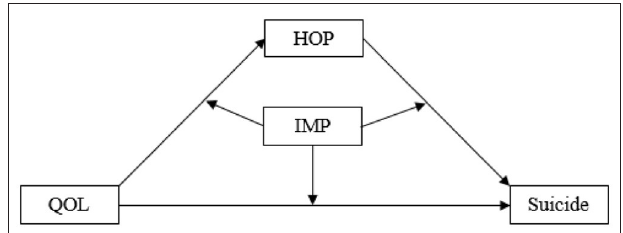
FIGURE 1 | A proposed moderated mediation model that links quality of life with suicide through hopelessness, modified by impulsivity. QOL, the quality of life; HOP, hopelessness;